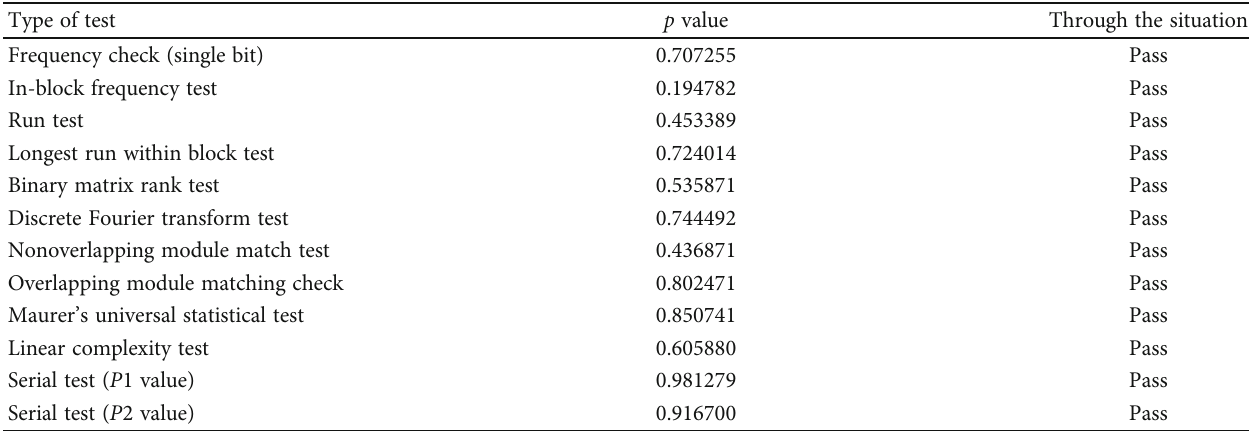
Figure 5: Lyapunov exponent plot of staged composite chaotic Table 3: Random test result.